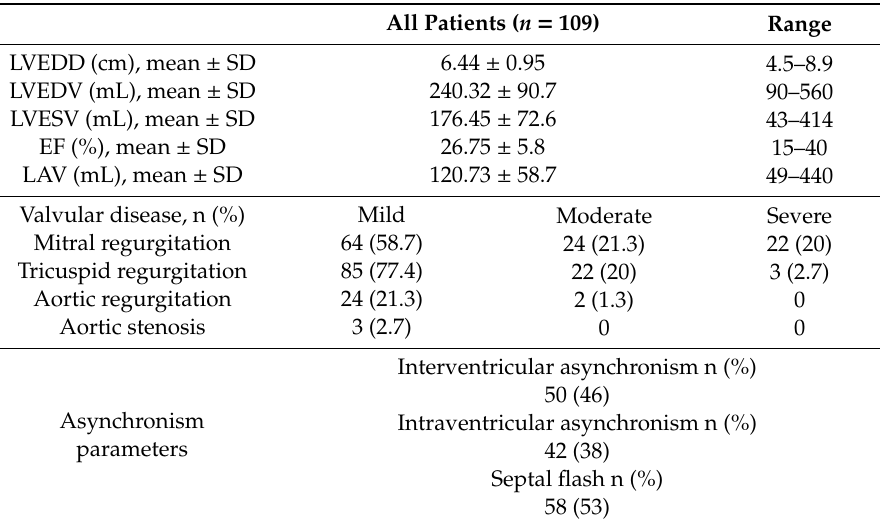
Table 2. Baseline echocardiographic data.